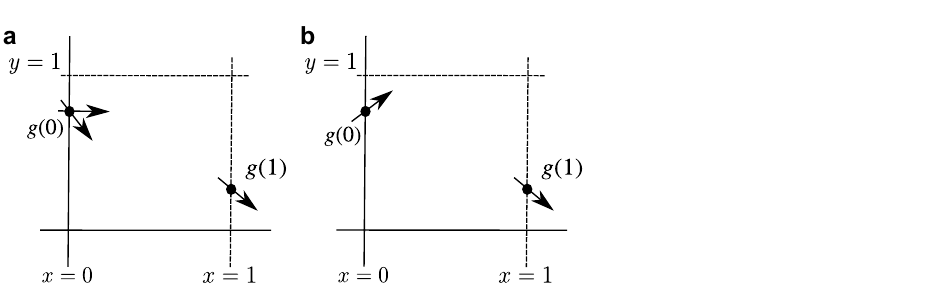
Figure 4. Graphical representation of some important properties of the polynomial g in the interval [0, 1]. ( a ) ( A 1 , A 2 , A 3 ) ∈ R 1 ∪ R 2 , and ( b ) ( A 1 , A 2 , A 3 ) ∈ R 3 . The arrow on the axes x = 0 and x = 1 represent the sign of g ′ ( 0 ) and g ′ ( 1 )